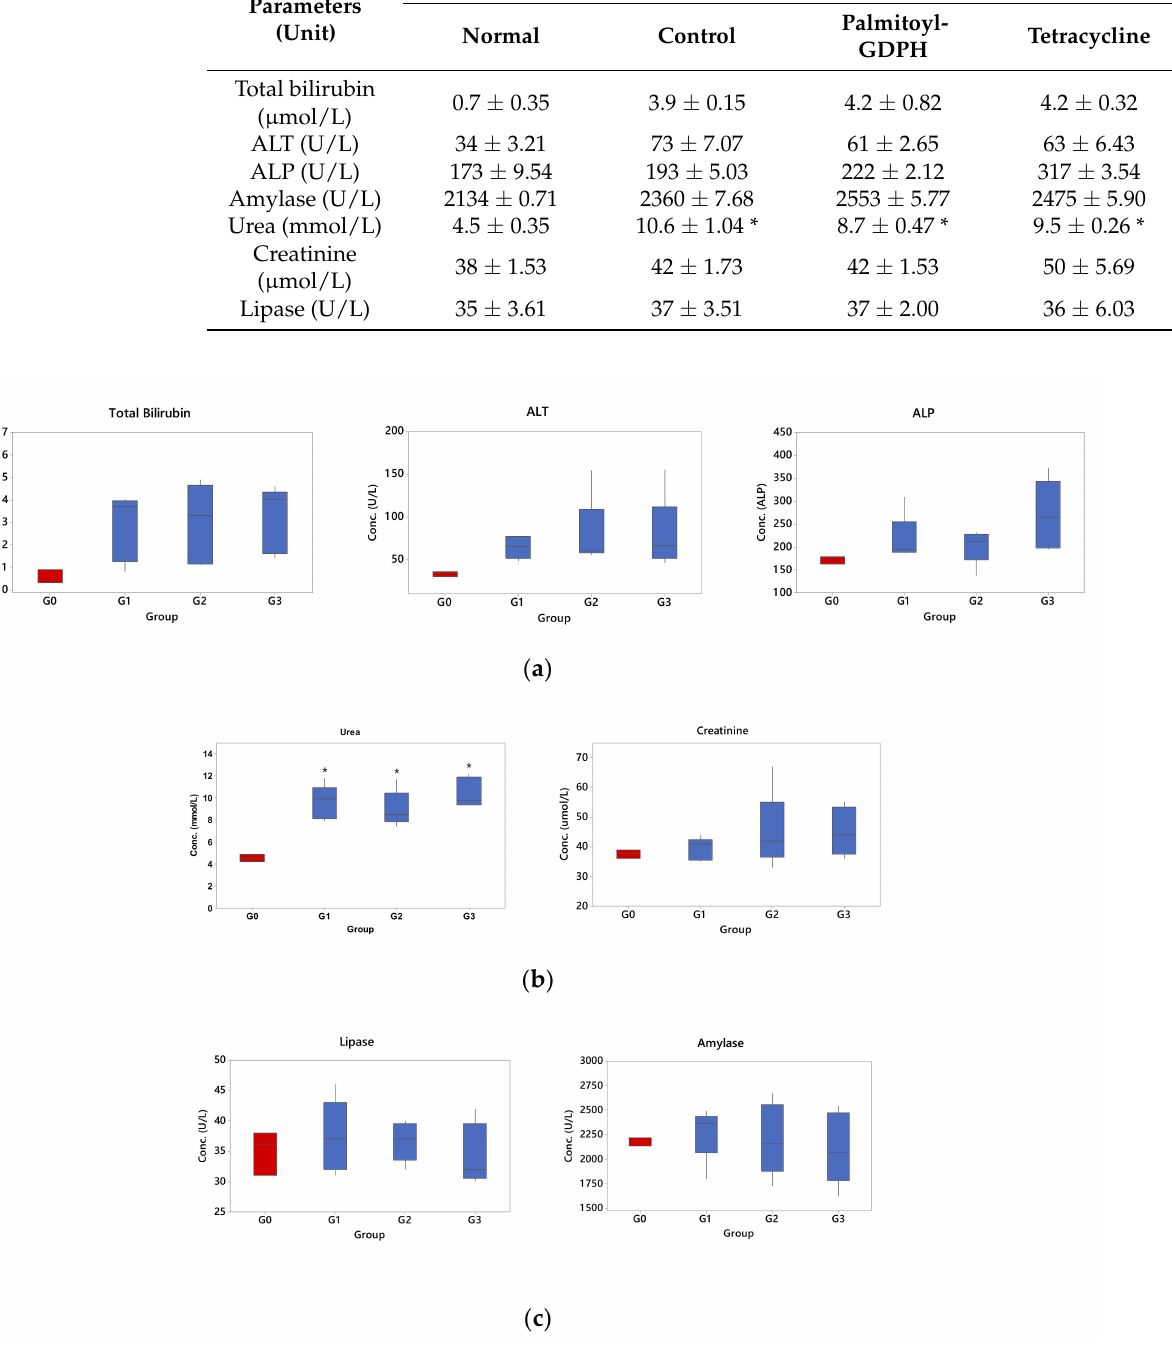
Figure 13. Chemistry analysis for indicators of organ function in blood; ( a ) Indicators for liver function (total bilirubin, ALT, ALP), ( b ) kidney (urea, creatinine) and ( c ) pancreas (amylase, lipase). The G0, G1, G2 and G3 represent Group 0 (normal rats), Group 1 (Control rats), Group 2 (Palmitoyl-GDPH treated rats), and Group 3 (tetracycline treated rats), respectively. The asterisks (*) represent significant difference (* p < 0.05) from normal